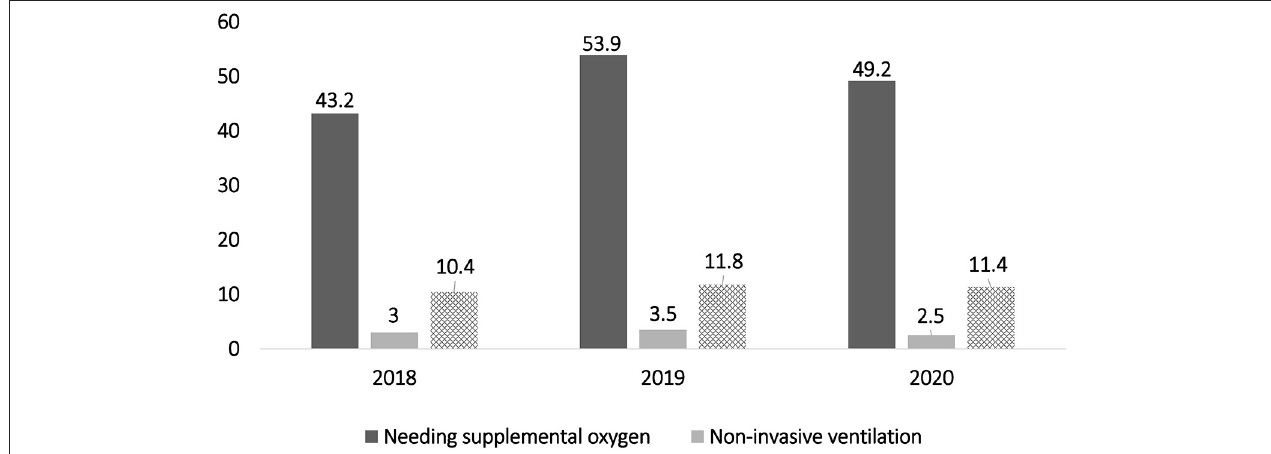
FIGURE 1 | Indicates similar patterns of oxygen and ventilation requirements during the early phase of the coronavirus disease pandemic compared to the previous 2 years.